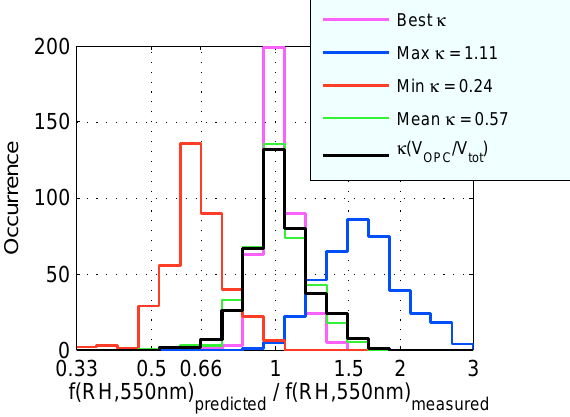
Fig. 11. Dry calculated versus dry measured scattering coefficients (at λ = 550nm) using a refractive index of ( NH 4 ) 2 SO 4 for the en- tire campaign and the measured dry size distribution (daily aver- ages, error bars denote standard deviation of the calculated and mea- sured one-hour values). A weighted linear least-square regression is added to the plot (black line).